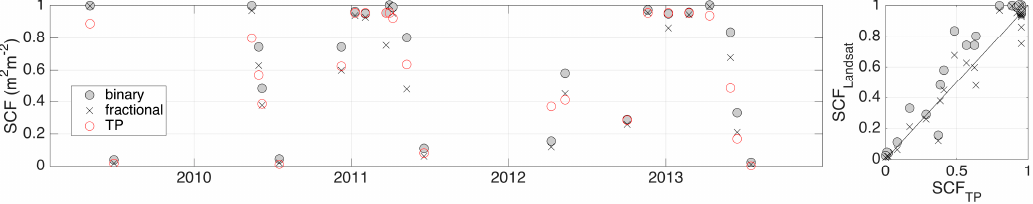
Figure 6. Evolution of SCF over the control area throughout the validation period (2009–2013) ( right ). Dispersion graph comparing the evaluated SCF obtained from Landsat with the validation dataset obtained calculated using TP ( left ).